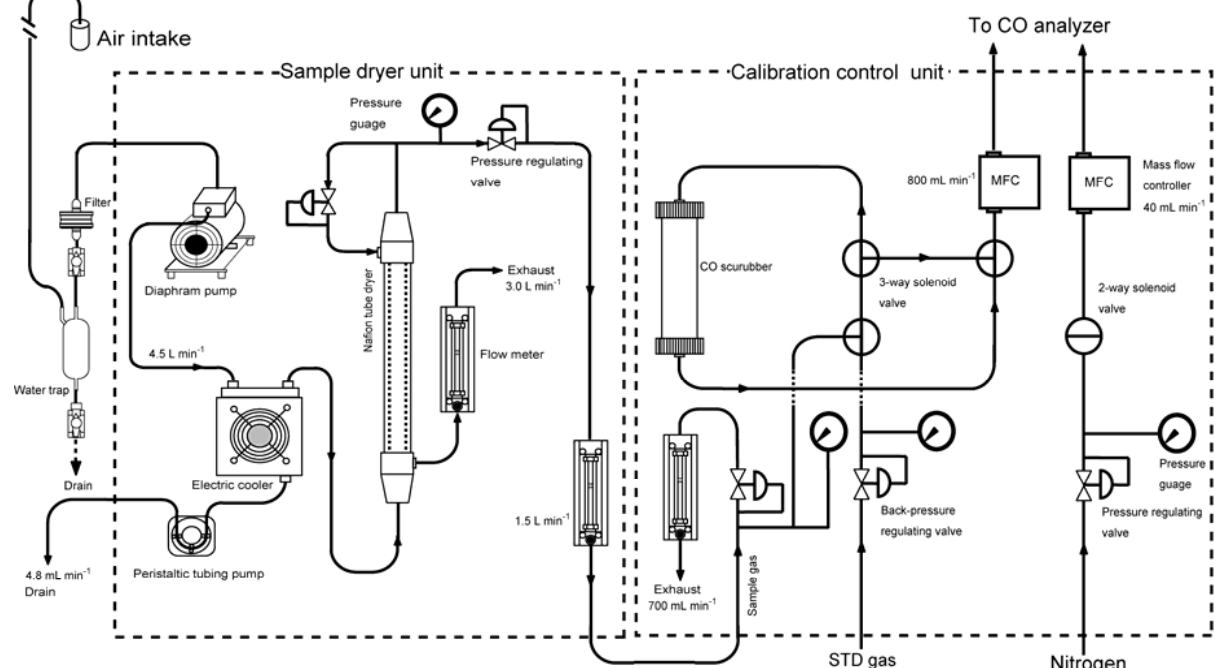
Fig. 3. Schematic diagram of the continuous CO measurement system, including a sample dryer and a calibration control unit. of 40 ml min − 1 , which is adjusted by means of another mass flow controller.